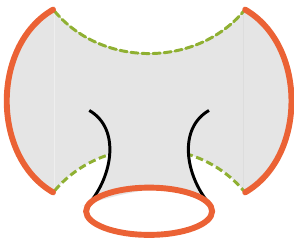
(cid:10) (cid:11) ( j ; i )( i ; j ) Z . The solid red lines